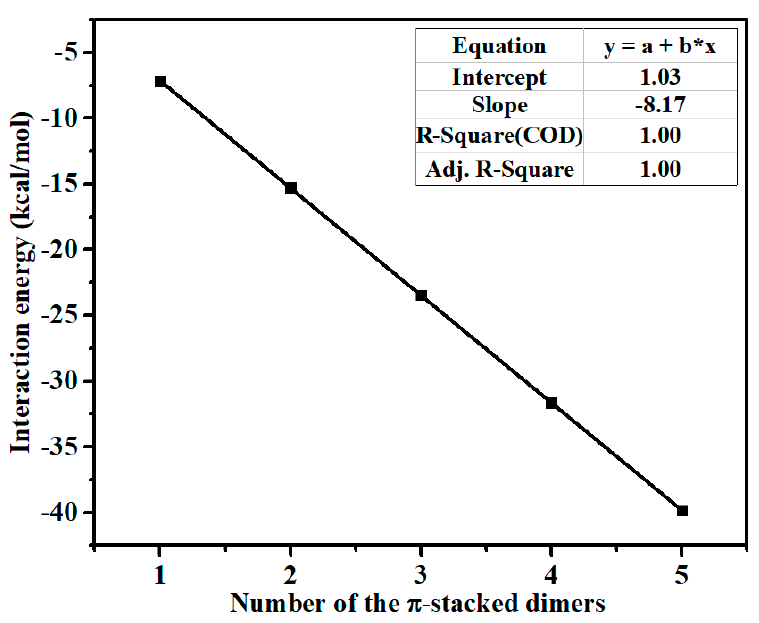
Figure 6. The correlation of the interaction energy with the number of π -stacked dimers.